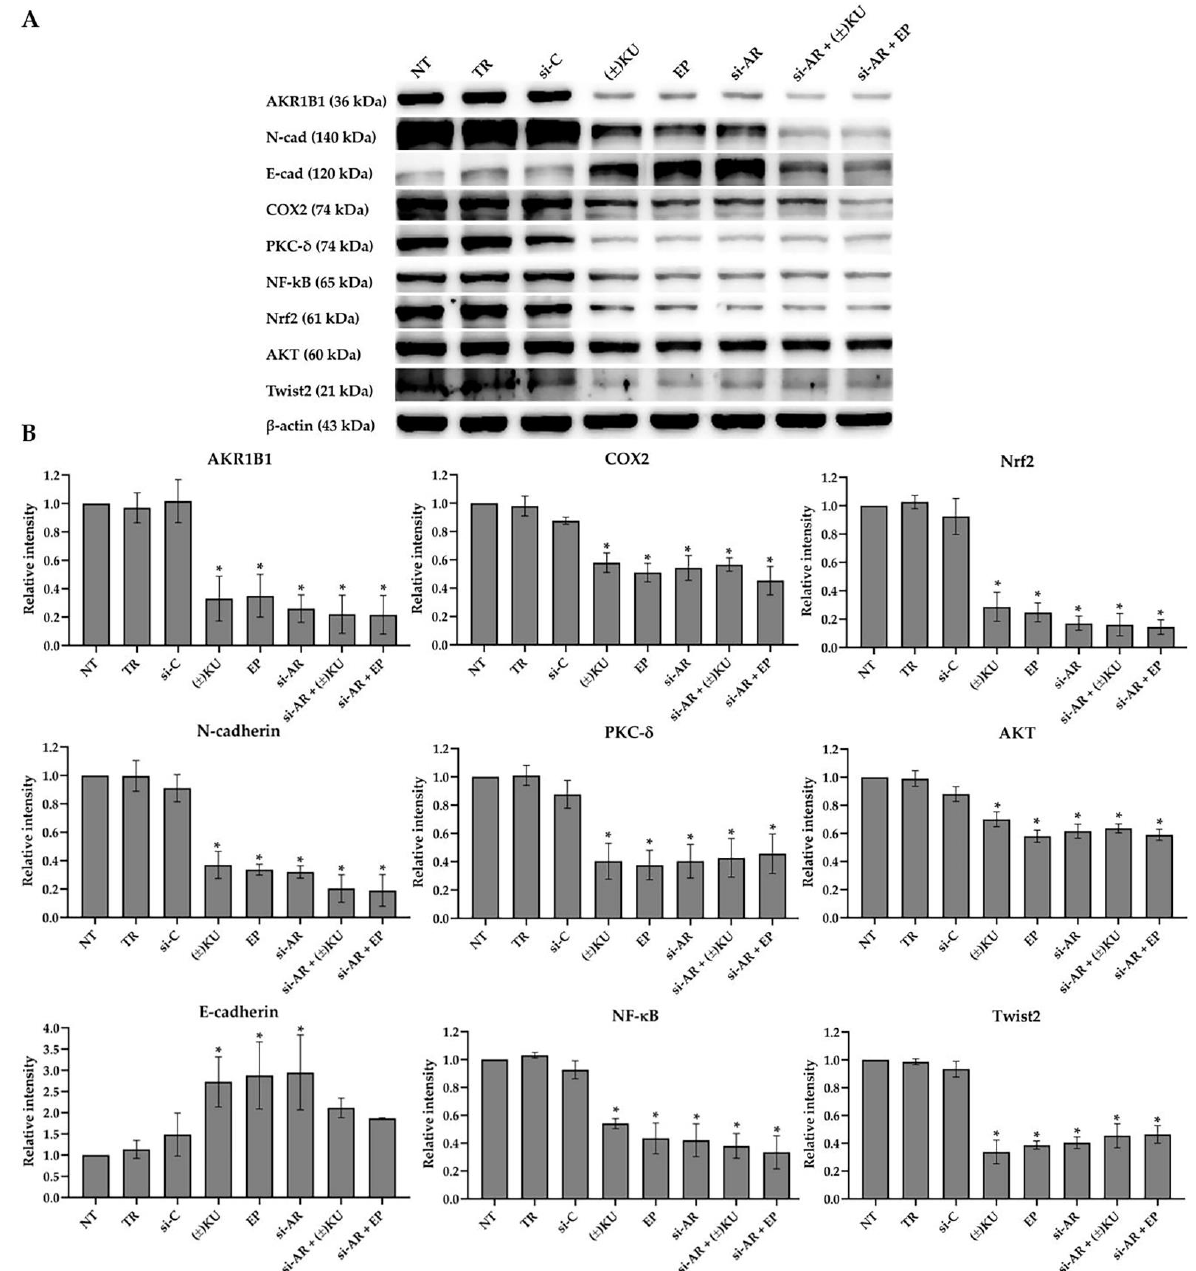
Figure 7. Effect of ( ± )KU, EP, siRNA-AKR1B1 and combination of compounds with siRNA-AKR1B1 on AKR1B1 and its downstream signaling molecules. Hs578T cells were treated with 2.79 µ M ( ± )KU or 48.04 µ M EP or 100 nM siRNA-AKR1B1 or a combination of 100 nM siRNA-AKR1B1 with each compound for 72 h. ( A ) The protein level of AKR1B1 and its downstream molecules (PKC δ , NF- κ B, AKT, Nrf2, COX2, Twist2, E-cadherin and N-cadherin) were determined by Western blot analysis. ( B ) Quantitative protein level of AKR1B1 and its downstream molecules were normalized with β -actin band intensity. Data are represented as mean ± SD with three independent experiments. Statistically significant differences between treated cells and non-treated cells were determined by a one-way analysis of variance followed by Tukey’s multiple comparison test (* p < 0.05). NT, non- treated cells; TR, DharmaFECT 4 transfection reagent; si-C, siGENOME non-targeting control; ( ± )KU, trans -( ± )-kusunokinin; EP, epalrestat; si-AR,